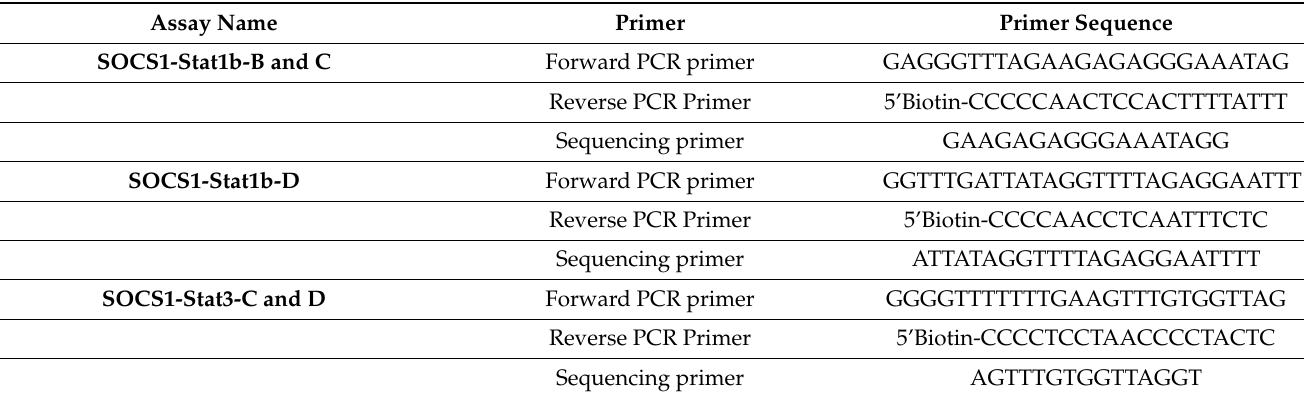
Table 1. Primer sequences for pyrosequencing